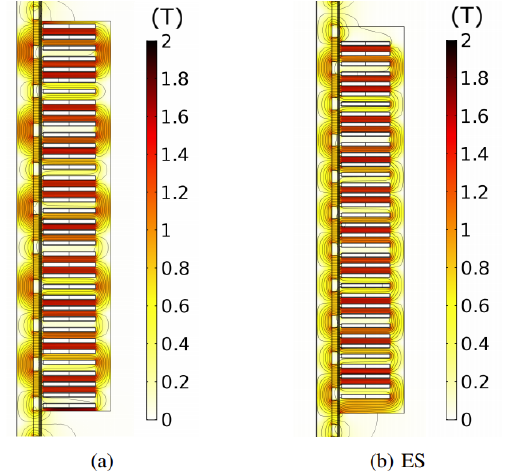
Figure 15. Detent force for buried (B) and surface-mounted (S) PMs with and without extended stator (ES). Full stator overlap for buried (B) and surface (S) topologies is from t = 0.6 s to t = 1.32 s and t = 1.2 s, respectively, indicated by the dashed vertical lines.